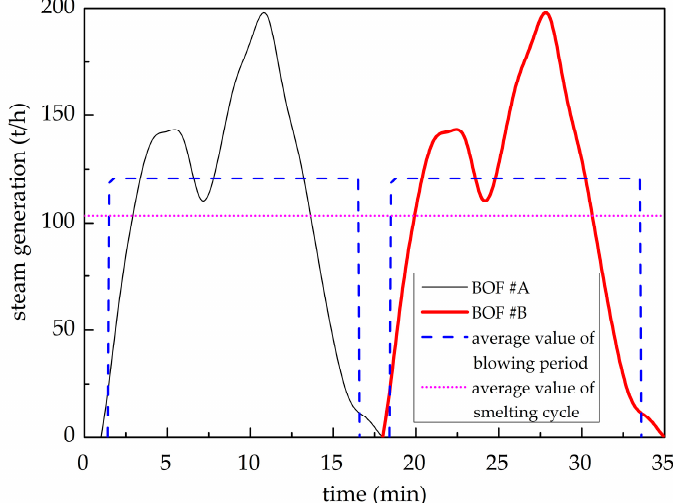
Figure 10. Steam generation of two 260 t parallel-operating BOFs. The fine line denotes the real-time load of BOF #A; the heavy line denotes the real-time load of BOF #B; the dashed line denotes the average value of the two BOFs of blowing period; and the short dot denotes the average value of the two BOFs of smelting cycle.